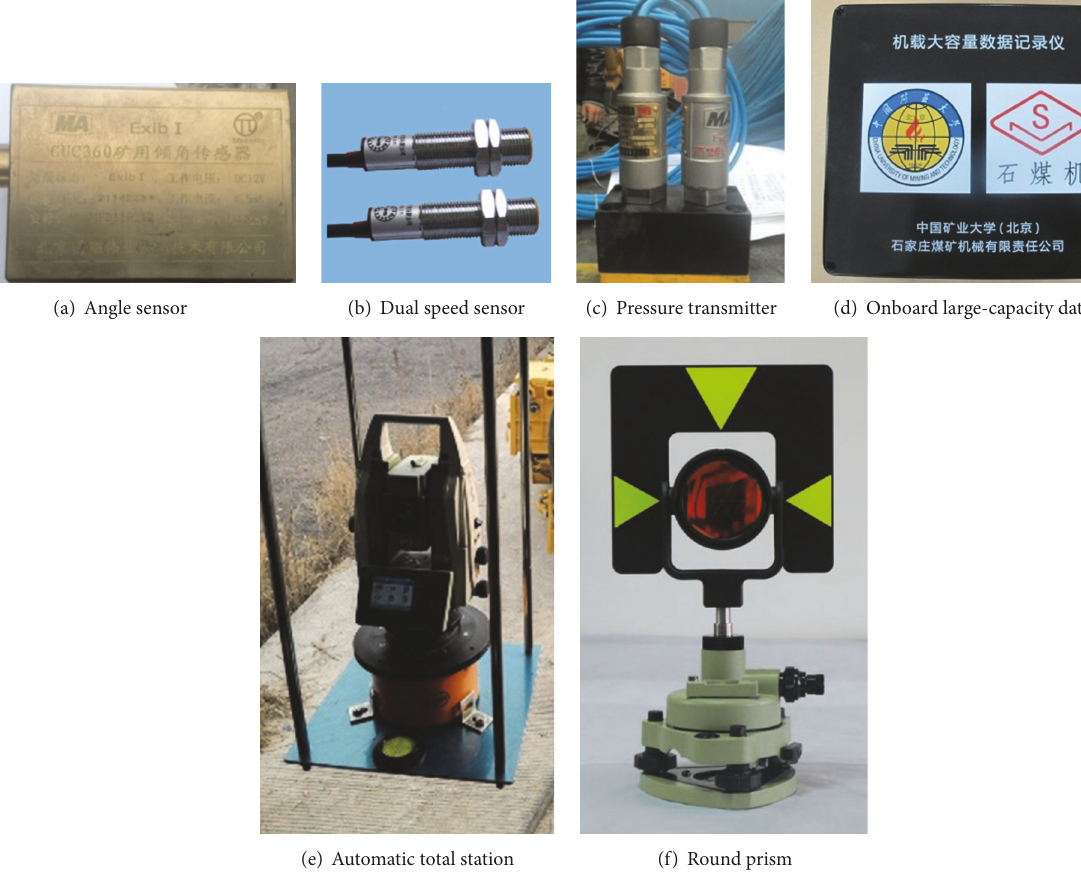
Figure 16: The pictures of the experiment equipment.